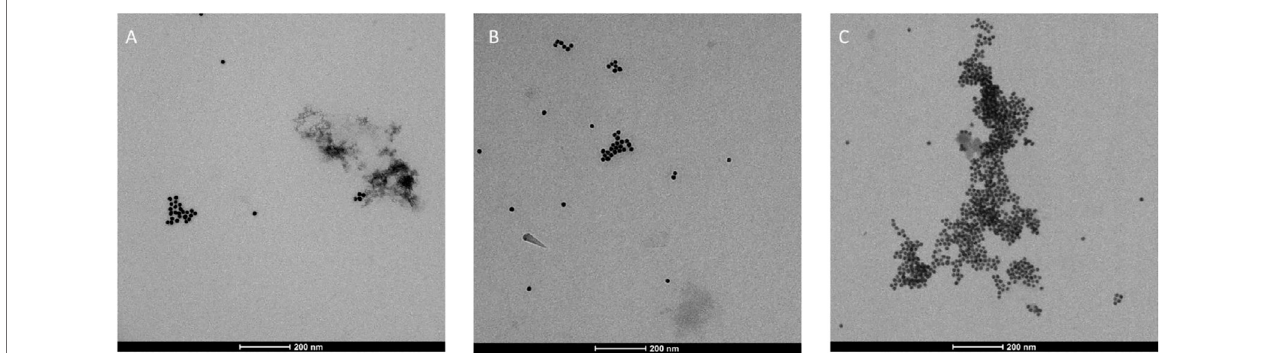
FIGURE 10 | TEM micrographs of avidin bound: (A) 3 + 9 @AuNPs, (B) 7 + 10 @AuNPs, (C) 7 + 9 @AuNPs.